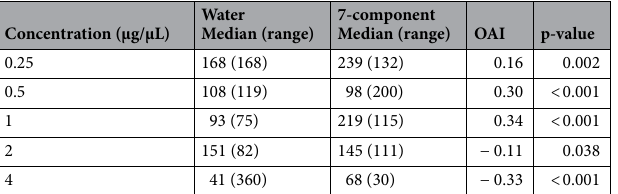
Compound Median (range)